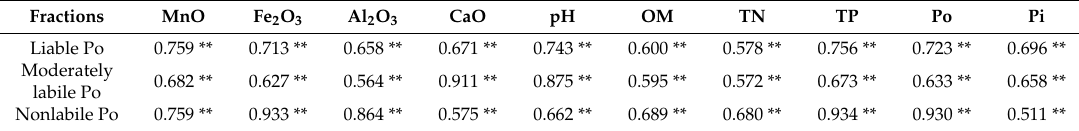
Table 3. The relationships between Po fractions and physiochemical